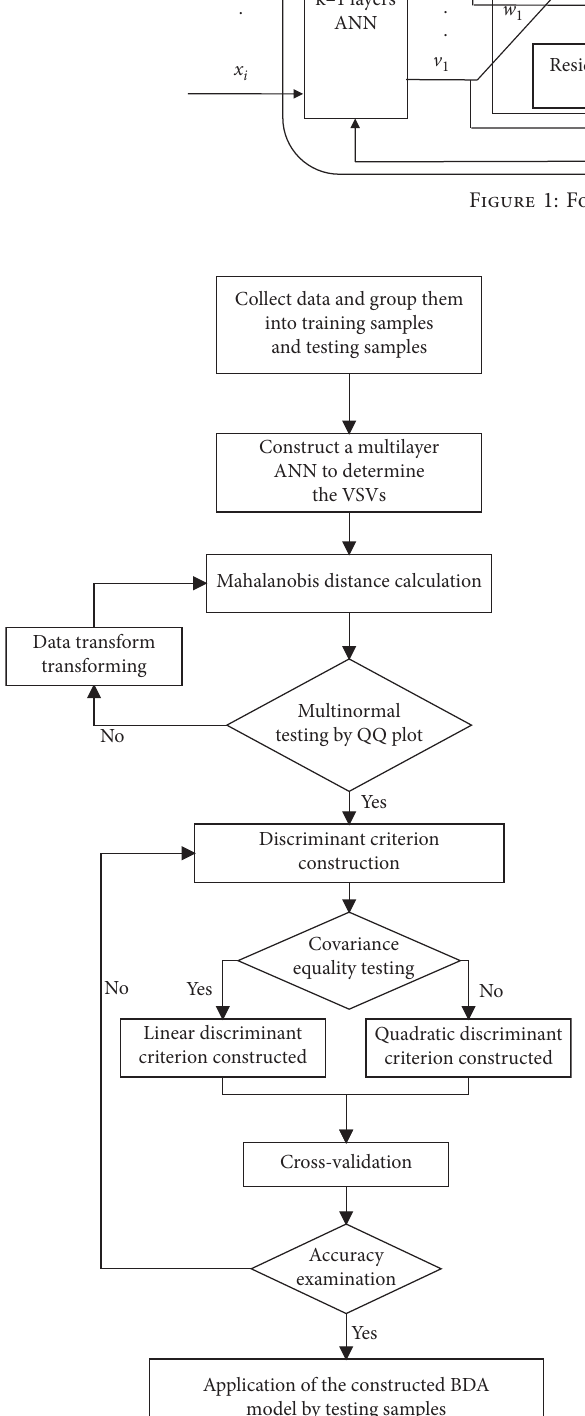
Figure 2: Flow chart of